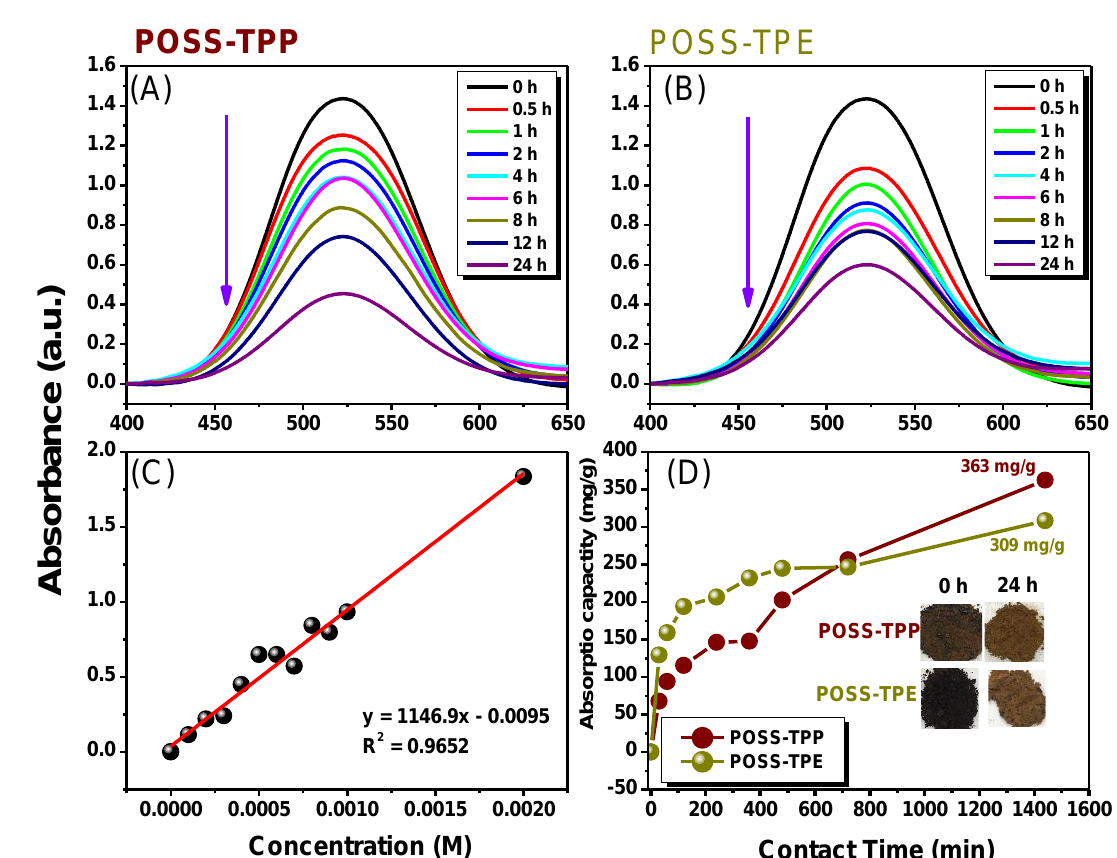
Figure 9. ( A,B ) UV-Vis absorption profile of the iodine solution after stirring POSS-TPP and POSS-TPE for different times (0 – 24 h). (C) The calibration curve of iodine was measured through recording the UV-Vis spectra of different I 2 concentrations in hexane. (D) Maximum absorption capacity of the iodine by the absorbents of POSS-TPP and POSS-TPE.